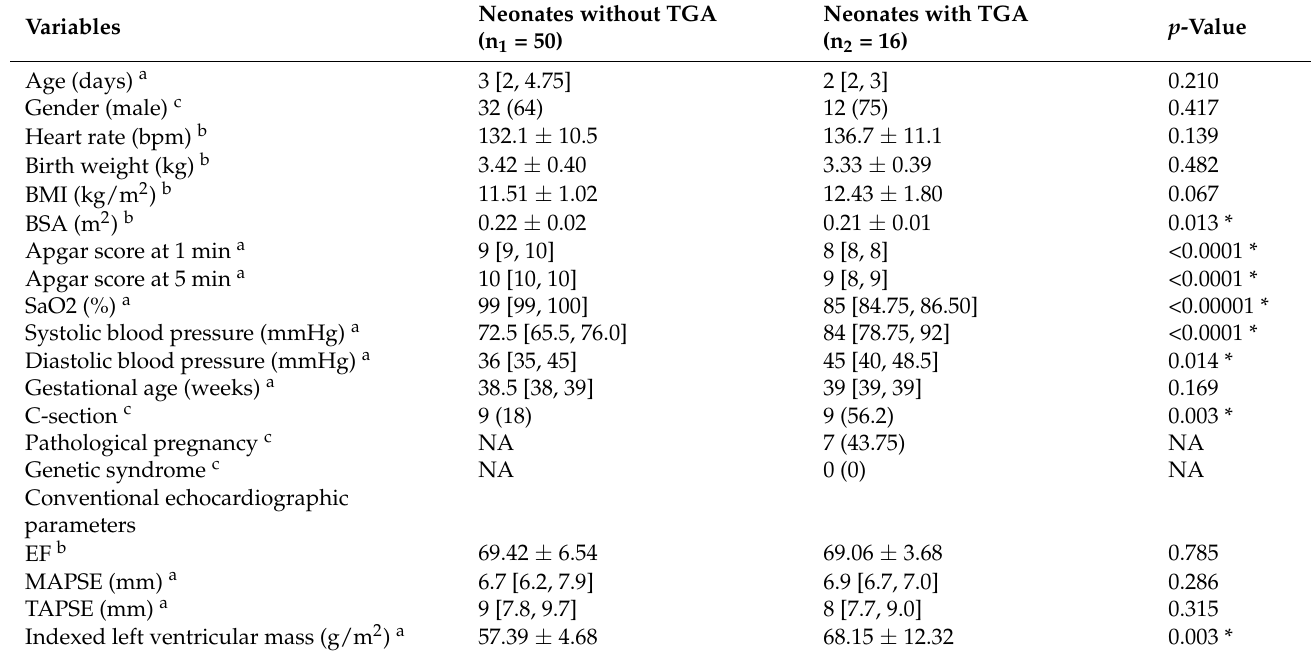
Table 1. Baseline characteristics of neonates without and with TGA.